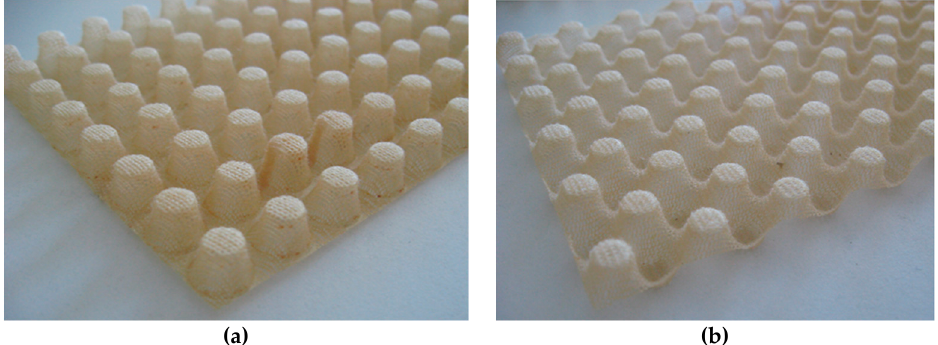
Figure 2. Single-sided nap-core ( a ), and symmetric nap-core ( b ).